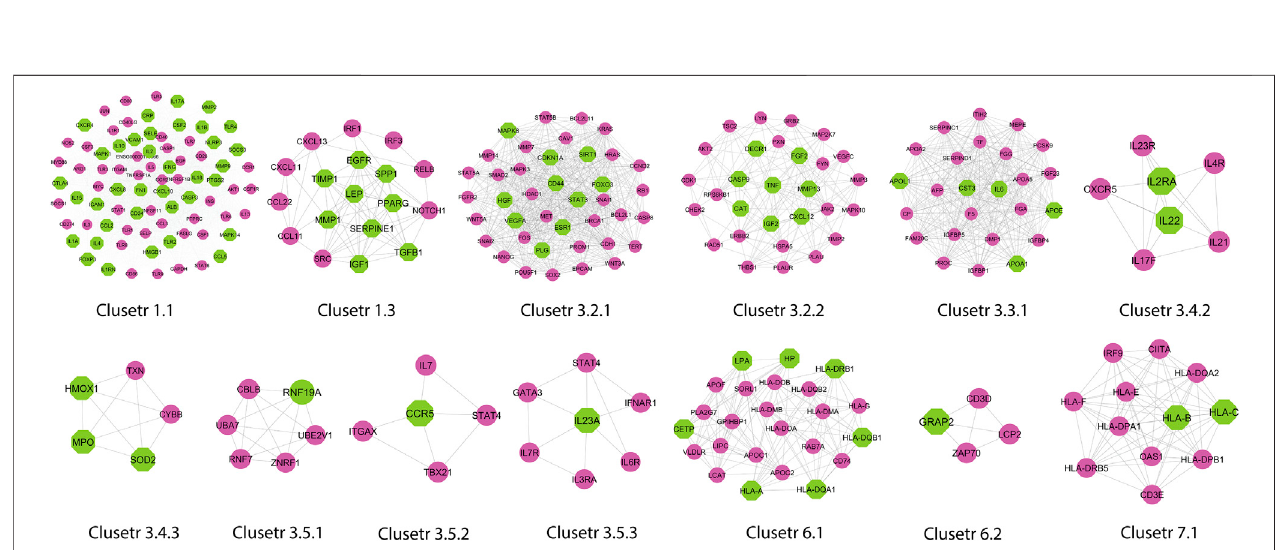
FIGURE 5 | Important modules (including motifs and rich clubs) in the network. These functional modules are common in tuberculosis and its associated NCDs.